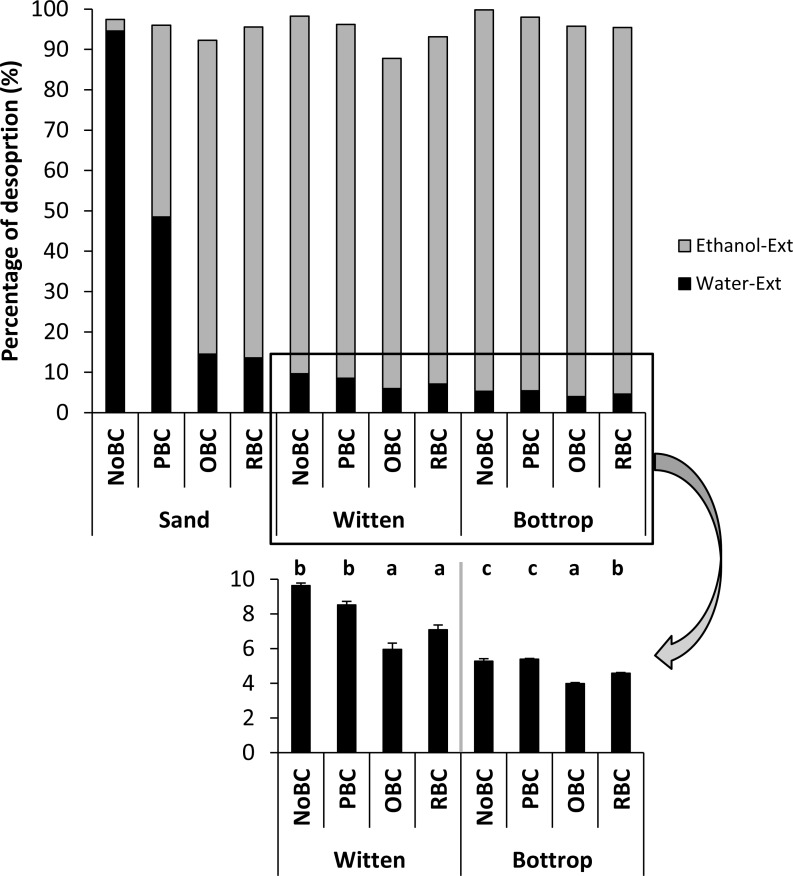
Desorption of Phe (as % of Phe in each sample) from sand and soils with different biochar treatments.Non-amended (NoBC) samples (sand, Witten soil, Bottrop soil) and samples amended by 1% (w/w) pine woodchips-derived biochar (PBC), olive pruning-derived biochar (OBC) and rice biochar (RBC). Samples from sorption experiment (1 mg Phe g −1 soil replicates) were used. For each extraction, with water and with ethanol, three subsequent fractions were produced and combined into one for each extractant. The results are presented as means ± SE (n = 3). The different letters denote significant differences (p < 0.05) between means.